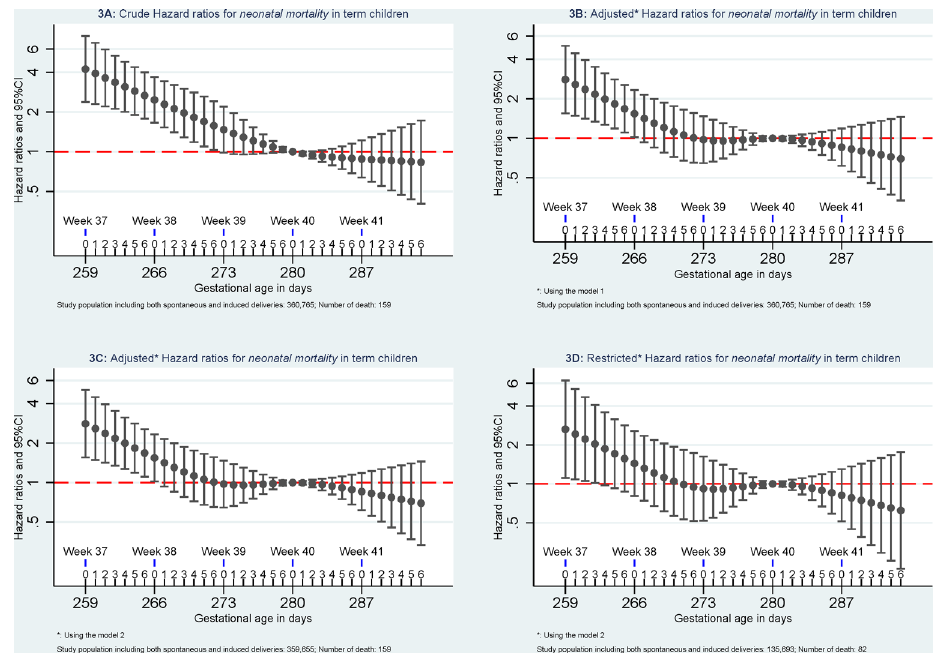
Fig 3. Hazard ratios for neonatal mortality. Model 1: the results were adjusted for caesarean section (yes or no), maternal age ( < 25, 25 – 30, 30 – 35, > = 35), parity (1, 2, and 3), and birth year (1997 – 1999, 2000 – 2002, 2003 – 2005, and 2006 – 2008). Model 2, the results were additionally adjusted for maternal education (low, middle, and high) and maternal cohabitant status during birth (yes, no). Restricted analyses: the analyses were restricted to pregnancies without registered morbidity within one year before delivery or within 30 days after delivery using the same adjustments in Model 2.